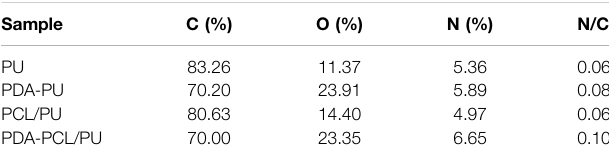
TABLE 2 | Surface chemical composition of